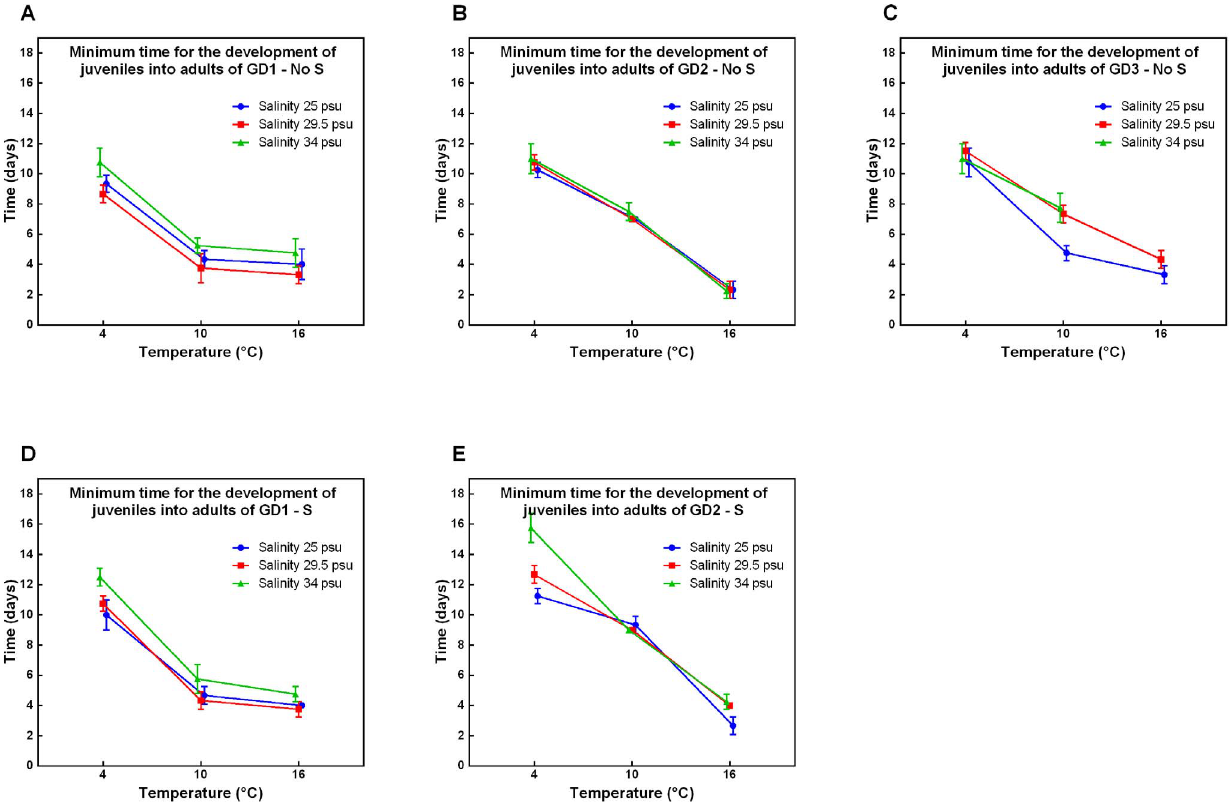
Figure 3. Minimum time for the development of juveniles into adults of GD1-3 under changing environmental conditions. Minimum time for the development of juveniles into adults in relation to temperature and salinity of cryptic Halomonhystera disjuncta species: GD1 (A, D), GD2 (B, E) and GD3 (C), in the absence (No S; A–C) and presence (S; D–E) of sulphide. The minimum time for embryonic development was calculated by subtracting the day we observe the first juvenile from the day we observed the first adult within the experimental microcosms. Data shown are mean values 6 1stdev of 3 or 4 replicates per treatment. No results were obtained for GD3 in the presence of sulphide because inoculated nematodes died within the first 1–2 minutes after adding Su.